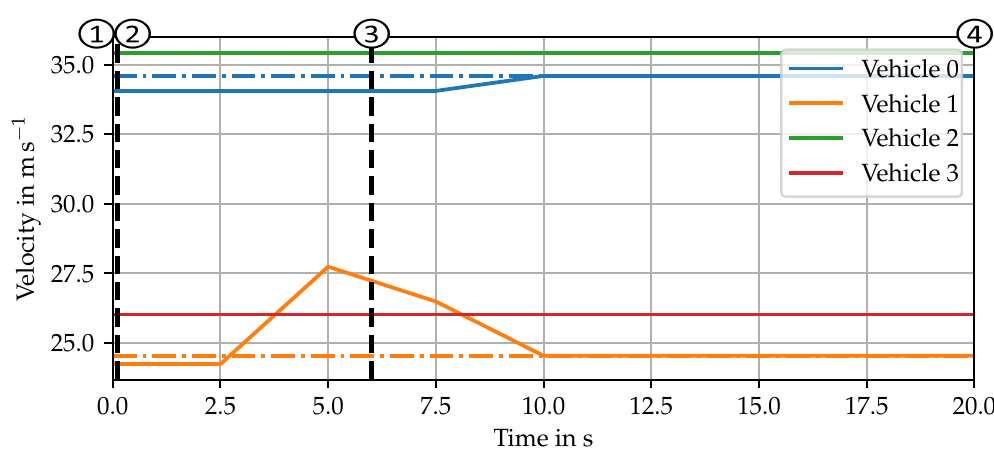
Figure 6. Longitudinal plot of the global planner.